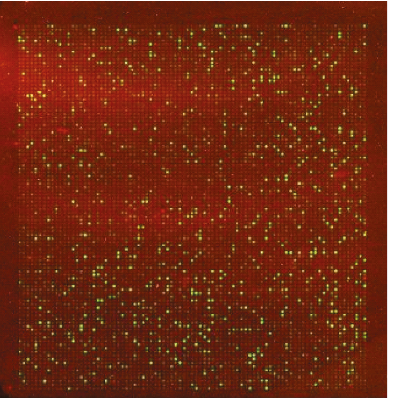
Figure 8: The custom microarray used for getting the data of the performance evaluation.